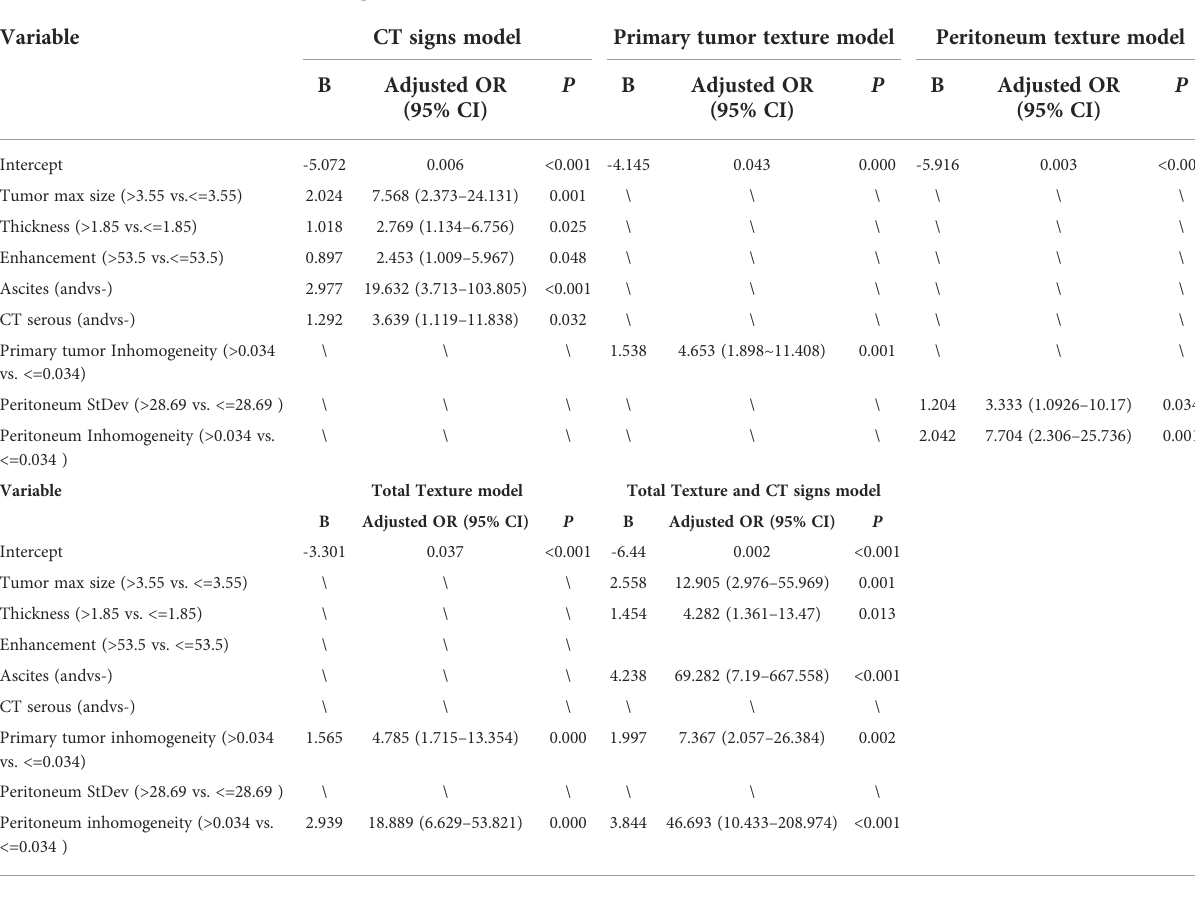
TABLE 3 Variables and coef fi cients of CT signs and texture features model.